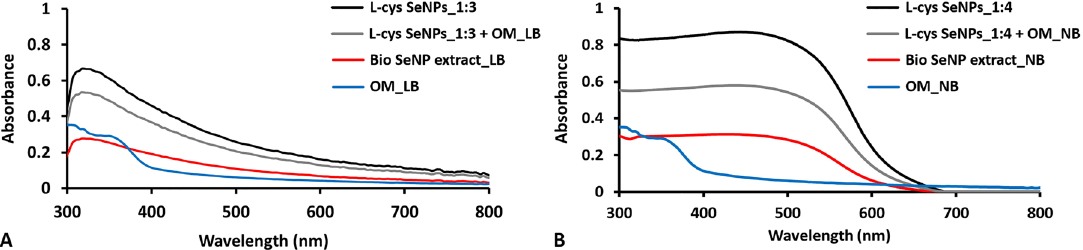
Figure 4: Absorbance spectra collected for samples containing SeNPs having ca. (A) 50 and (B) 100 nm as average diameter and their correspondent OM (i.e., OM_LB and